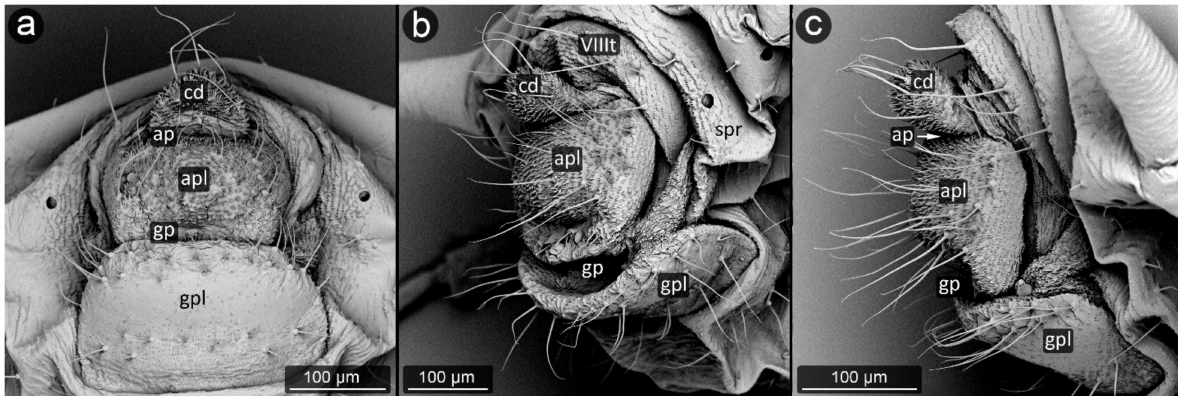
Figure 24. Perianal structure of Brachycaudus cardui in SEM; ( a )—rear view, ( b , c )—lateral view; (spr—spiracle). Dysaphis anthrisci Börner, 1950 (Figure 25).